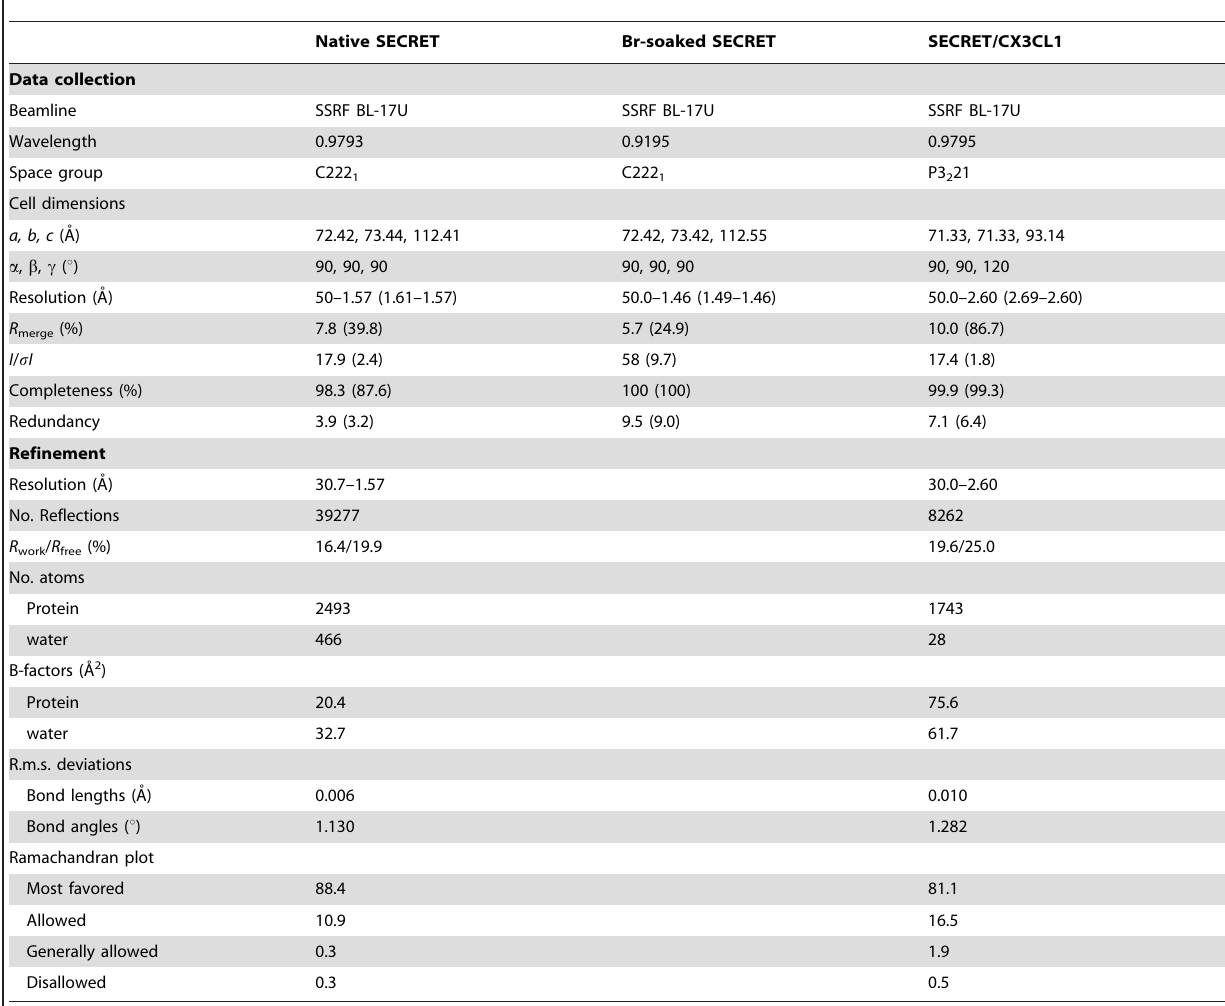
Table 1. Crystallographic